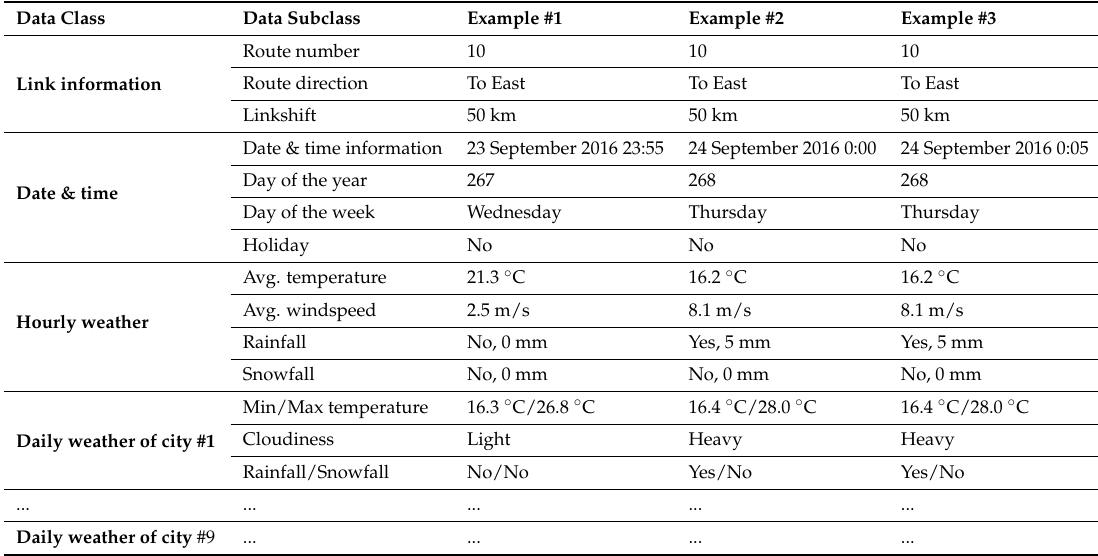
Table 1. Examples of input data used in our traffic forecasting